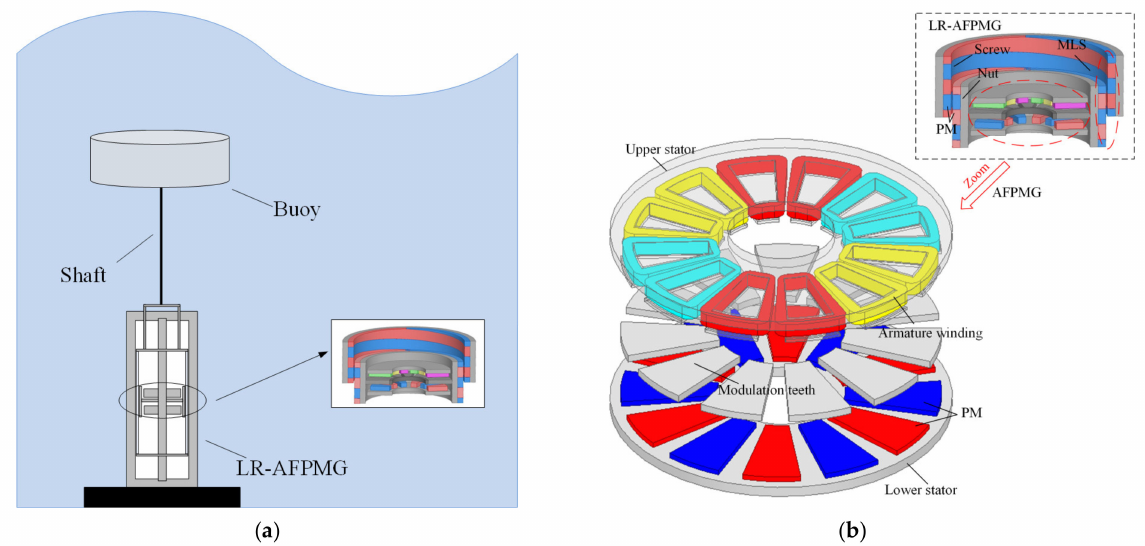
Figure 1. Configuration of UDDWEC system and LR-AFPMG: ( a ) Configuration of UDDWEC system; ( b ) Configuration of